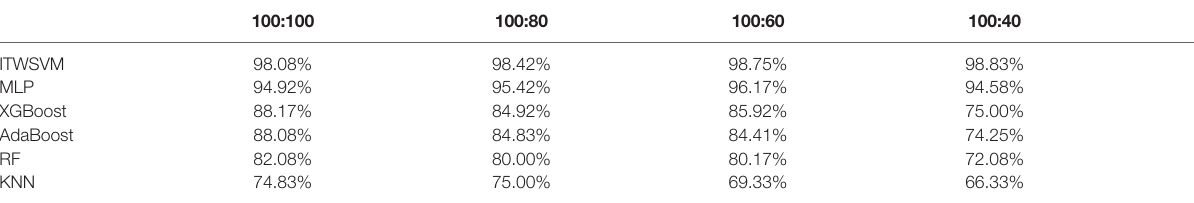
TABLE 3 | The comparison of average accuracy for various IR.